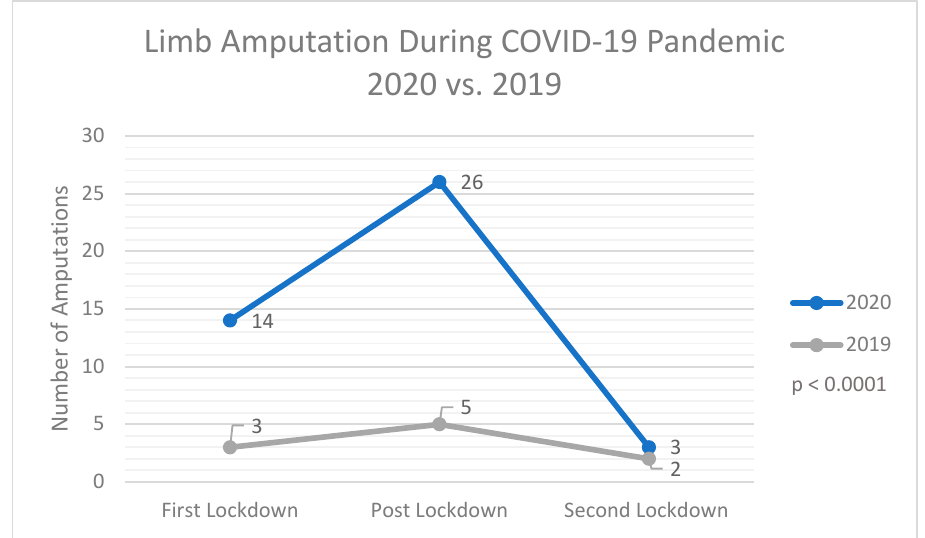
Figure 2. Numbers of limb amputations performed during the first LD, post-LD, and second LD periods in 2020 in comparison with similar time periods in 2019.